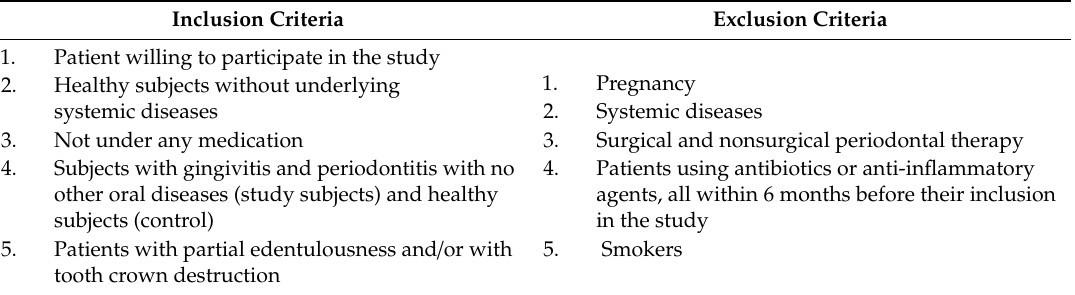
Table 3. Selection criteria of the study subjects in the